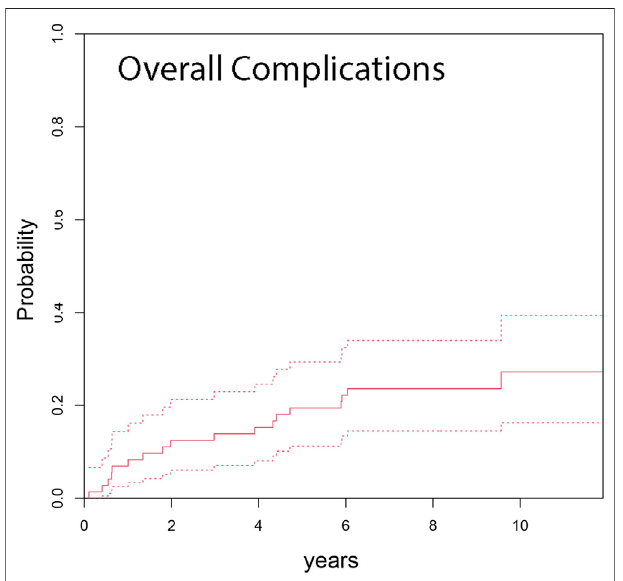
FIGURE 4 | Cumulative incidence function from competing risk data for complicationsassociatedwithimplantfailure(Type3complications)showsan occurrence of 5.6% at minimum 7 years follow up (dashed lines indicate 95%